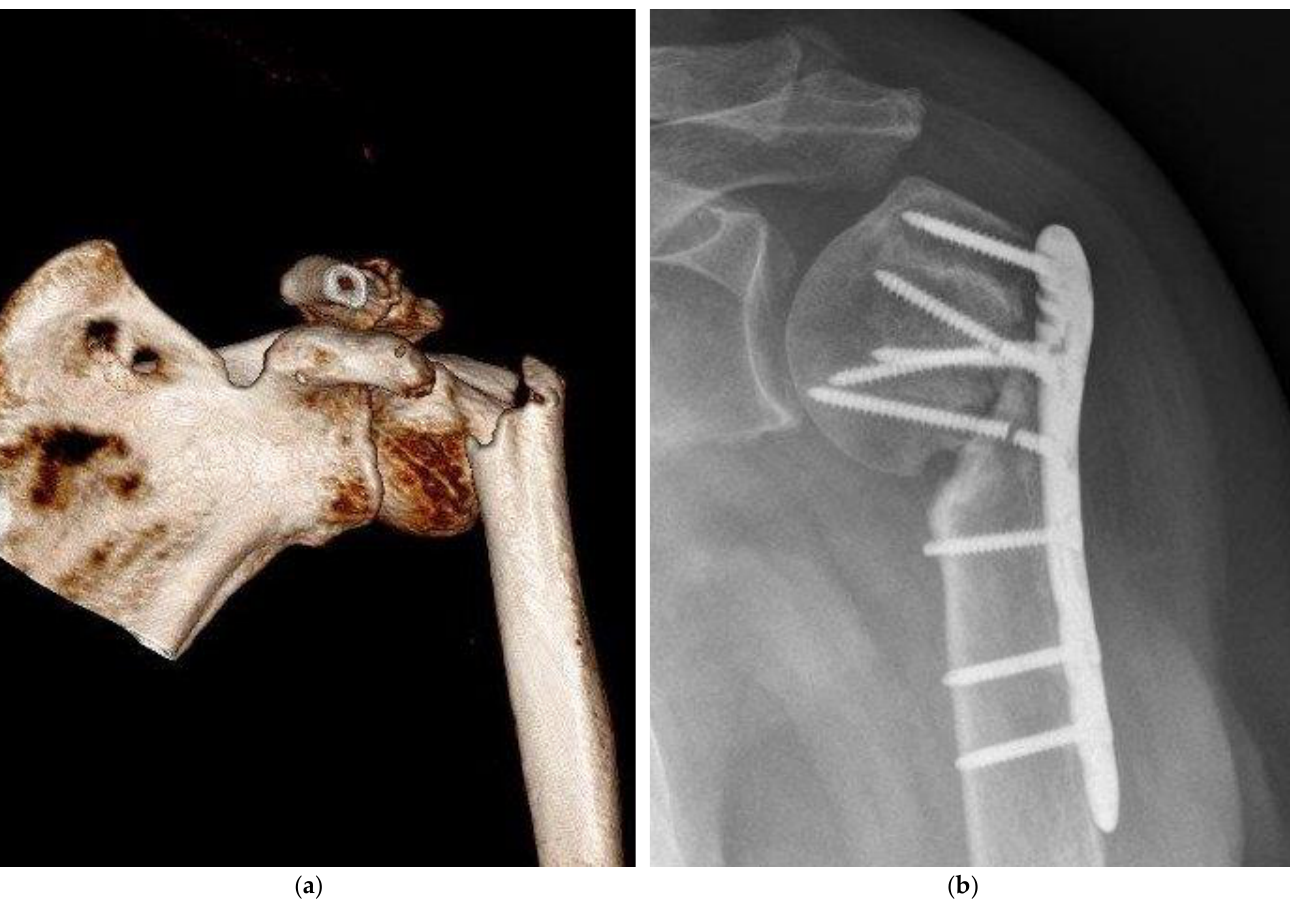
Figure 3. Severe complication, pseudarthrosis, resulting from a proximal humeral fracture, resulted by empty defect treatment. ( a ) Preoperative 3D CT reconstruction showed a sub-capital humeral fracture; ( b ) post-surgical care radiograph examination demonstrated an atrophic nonunion. Furthermore, two screws of the humeral head were broken.